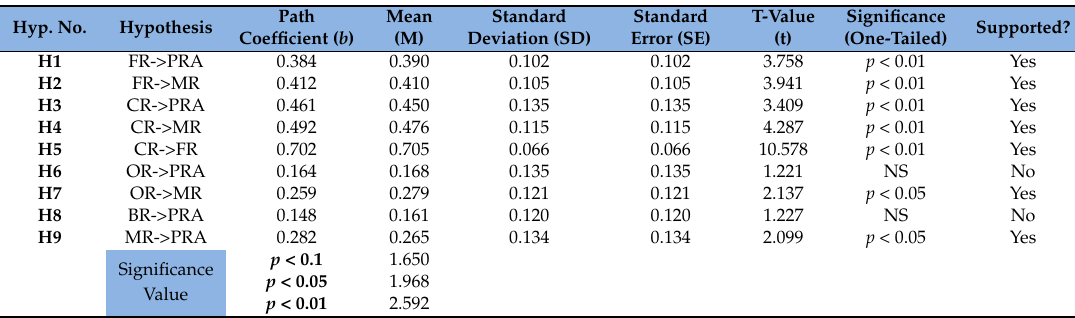
Table 6. Summary of the Hypothesis